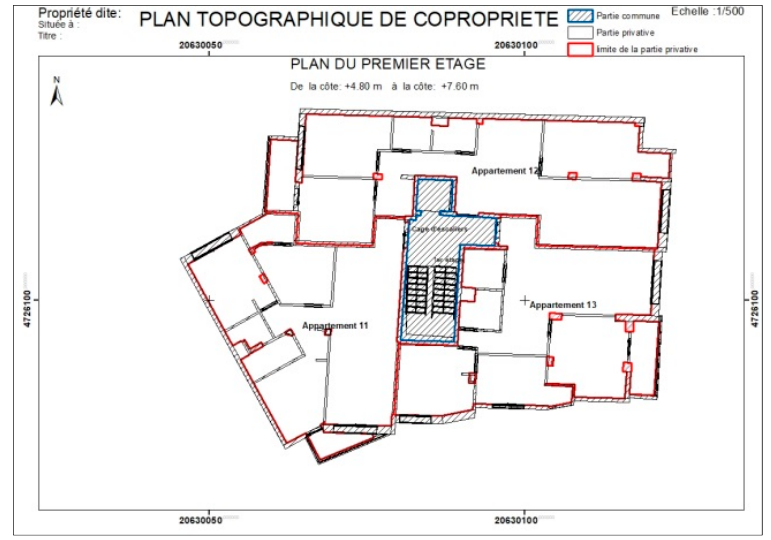
Figure 15. An extracted 2D plan according the formal specifications of ANCFCC.